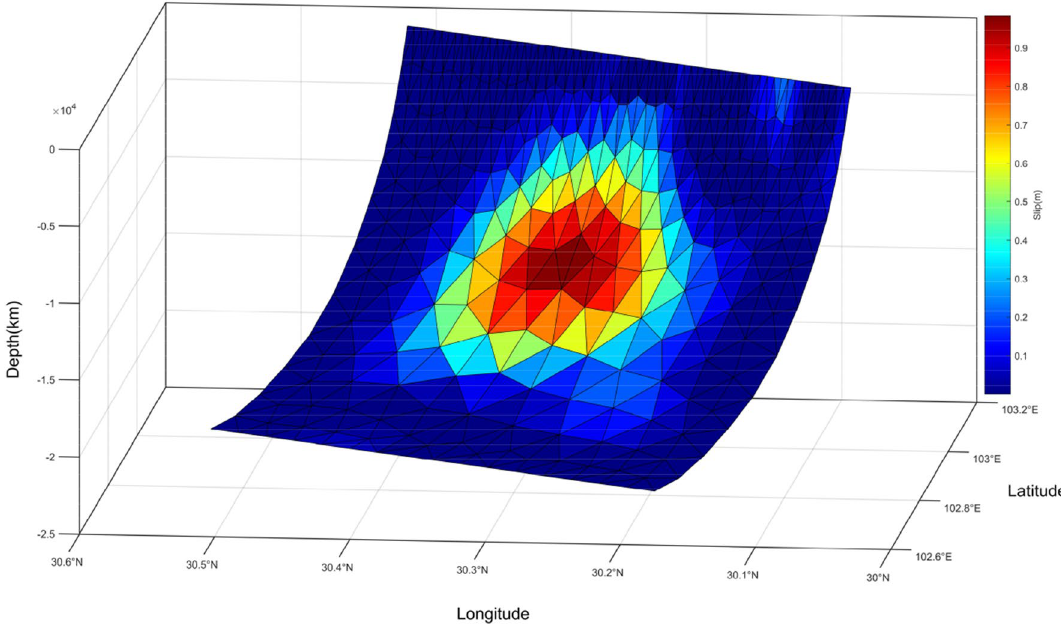
Figure 5. Coseismic slip distribution of the Lushan earthquake.